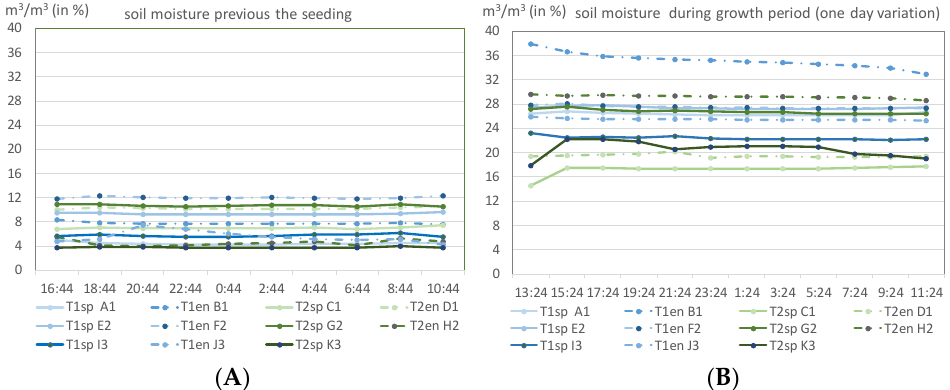
Figure 2. One-day data of soil moisture measured every two hours using the soil electromagnetic sensors, prior to the seeding ( A ) and during the growth period ( B ).